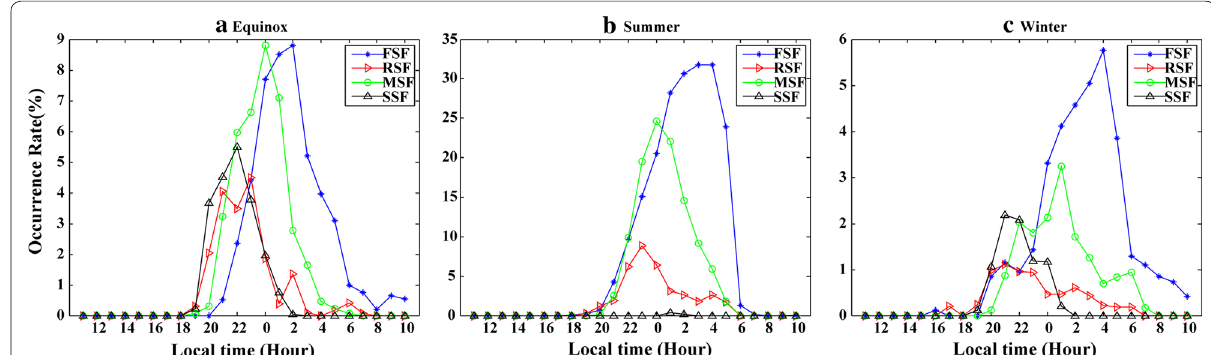
Fig. 2 SF occurrence rates for 2015–2016 as a function of local time (LT) for different